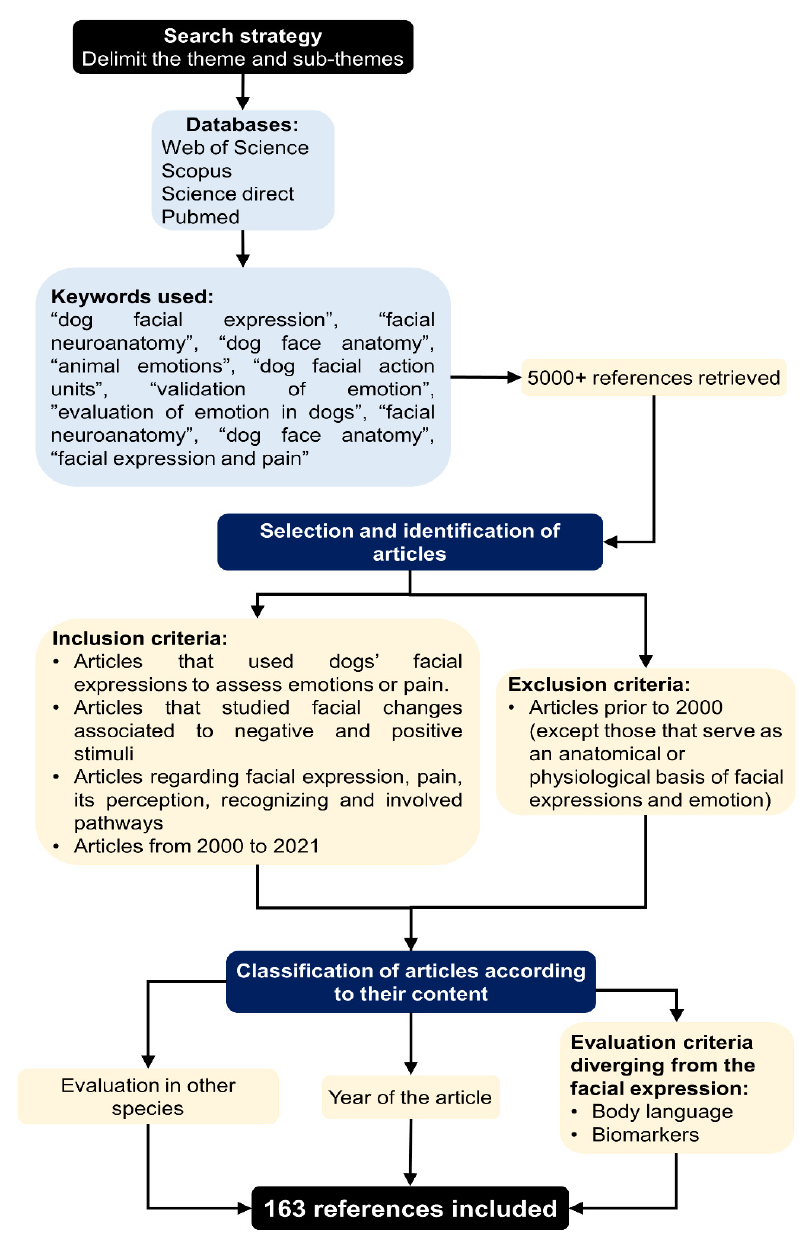
Figure 1. Review methodology.